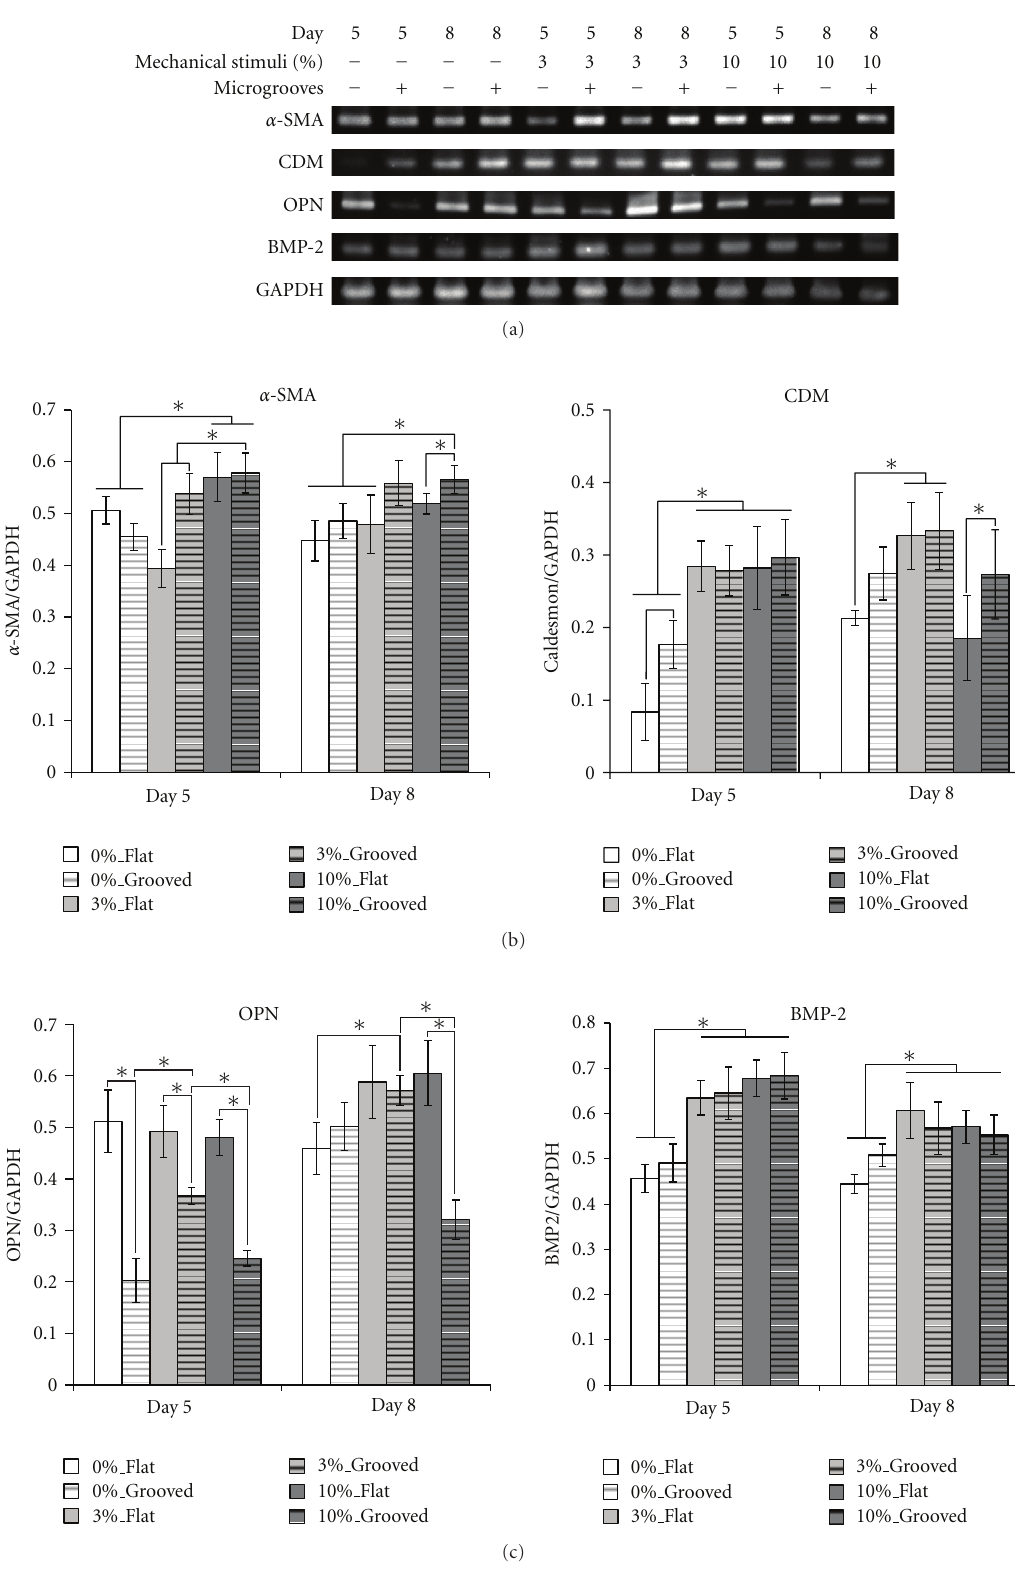
Figure 5: Gene expression of MSCs. (a) Gene expression profiles for each marker with/without mechanical stimuli or microgrooves. The expression levels of each gene are normalized by the expression of GAPDH; (b) smooth muscle cell-related genes; (c) osteoblast-related genes. Days 5 and 8 represent the time points immediately after stimuli ceased and 3 days after stimuli ceased, respectively. (All data are represented as mean ± SD. n = 3, ∗ denotes P ≤ .